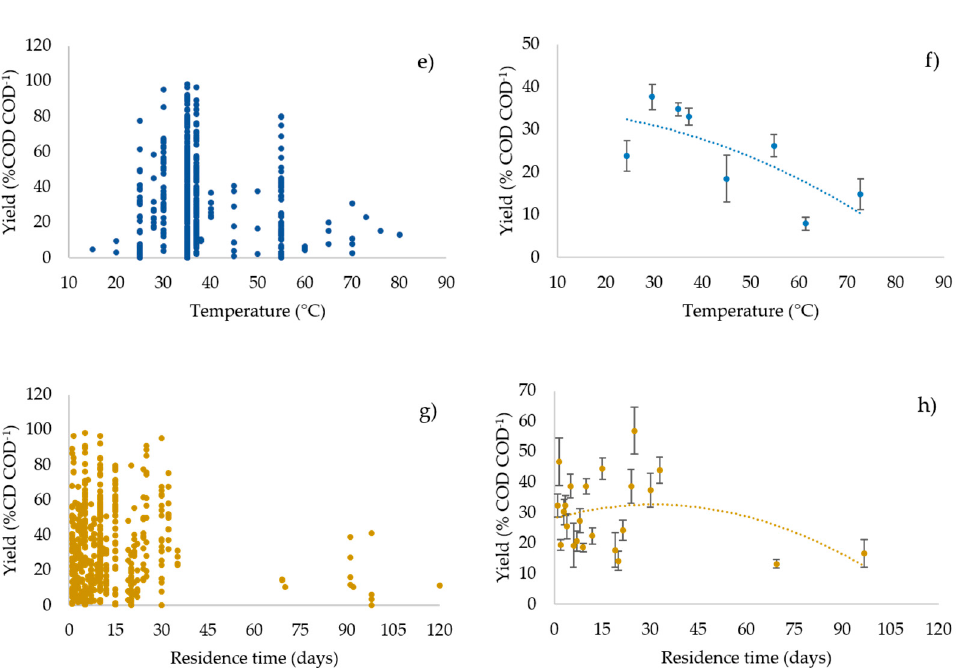
Processes 2020 , 8 , x FOR PEER REVIEW